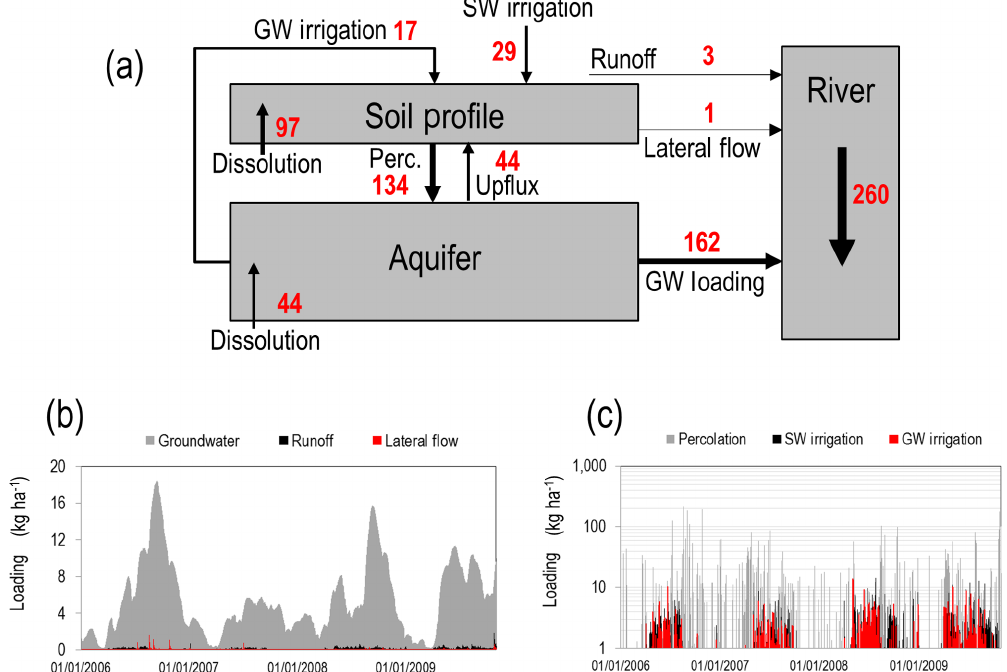
Figure 13. Magnitude of salt balance components in the watershed model for TDS, showing (a) relative salt flux between soil storage compartments in the watershed for each salt transport pathway; (b) daily loading (kgha − 1 ) of salt in groundwater, surface runoff, and lateral flow to streams; and (c) daily loading (kgha − 1 ) of salt in percolation water (from the bottom of the soil profile to the aquifer), irrigation derived from irrigation canals, and irrigated derived from groundwater